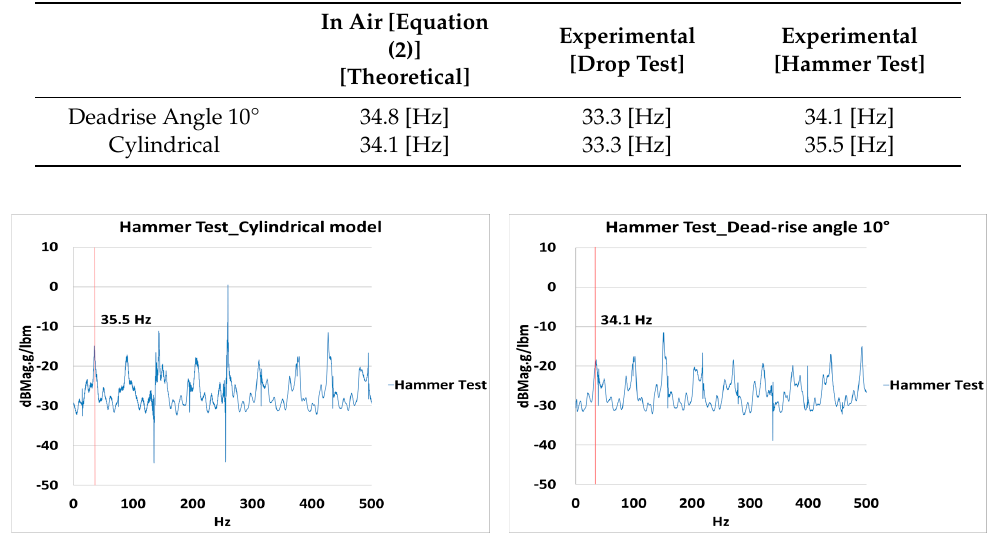
Figure 15. Hammering test result for cylindrical model (left) with deadrise angle of 10° (right). Table 6. Natural frequency from theoretical calculation, free-drop test, and hammer test.